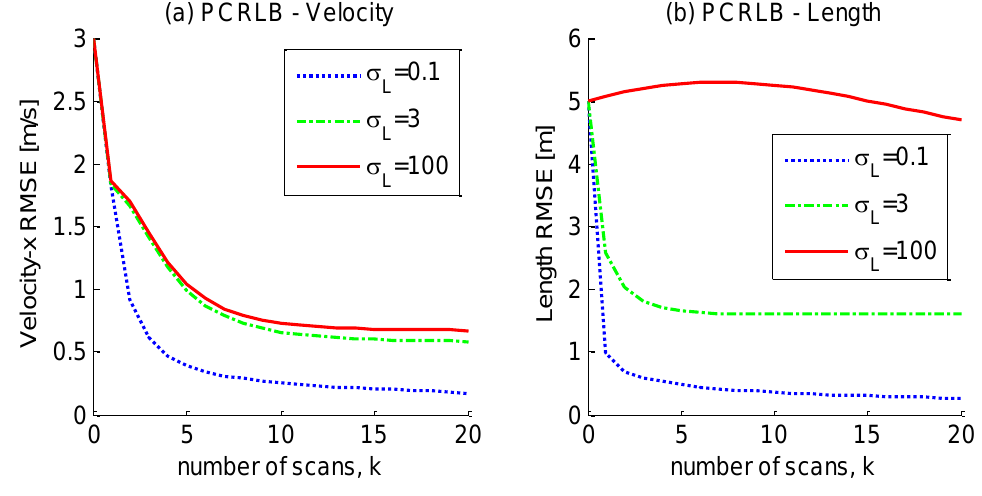
Figure 3. The comparison of the PCRLB curves for different values of target velocity in the direction of the x axis and (b) the target